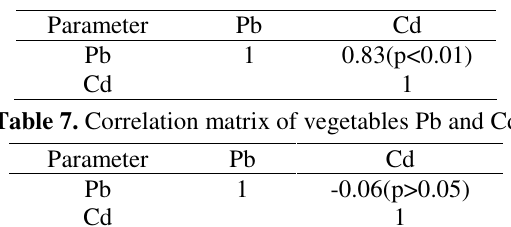
Table 6. Correlation matrix of soil Pb and Cd